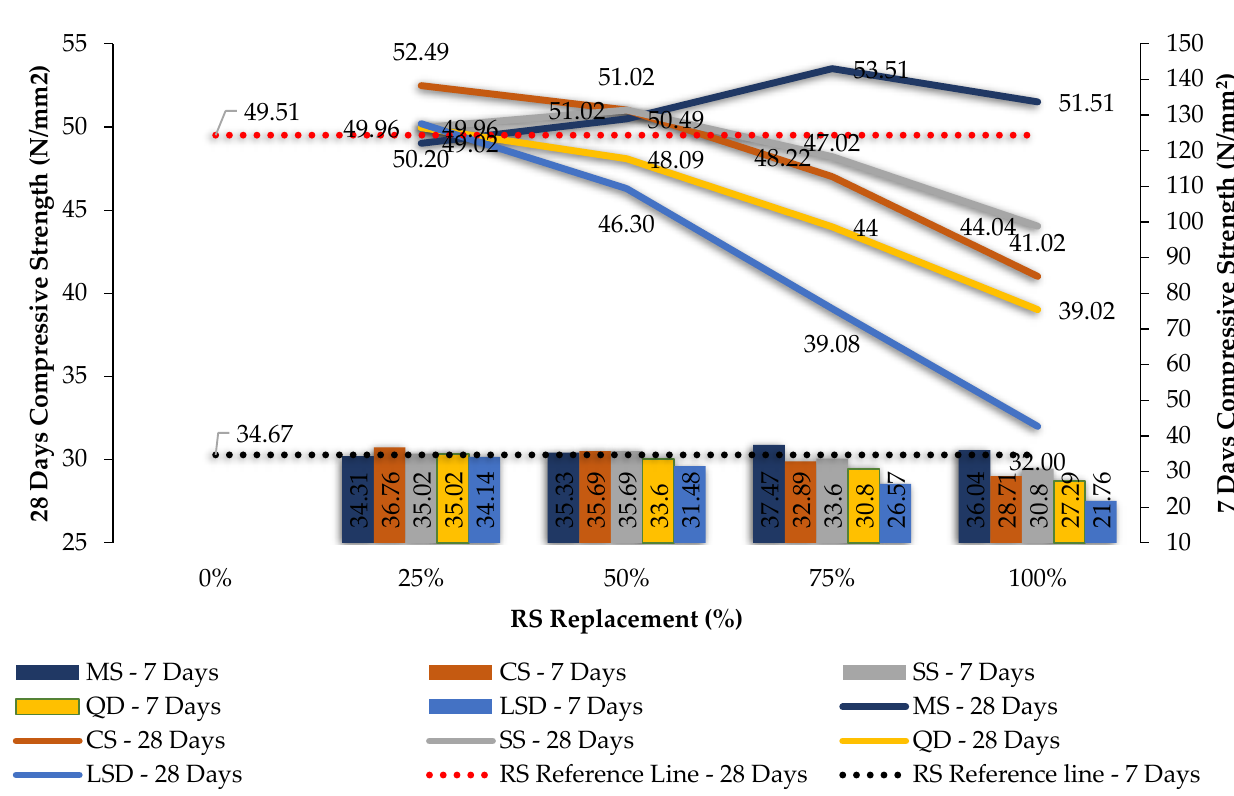
Figure 7. The 7- and 28-day compression test results for M 40 CC with various fine aggregates.